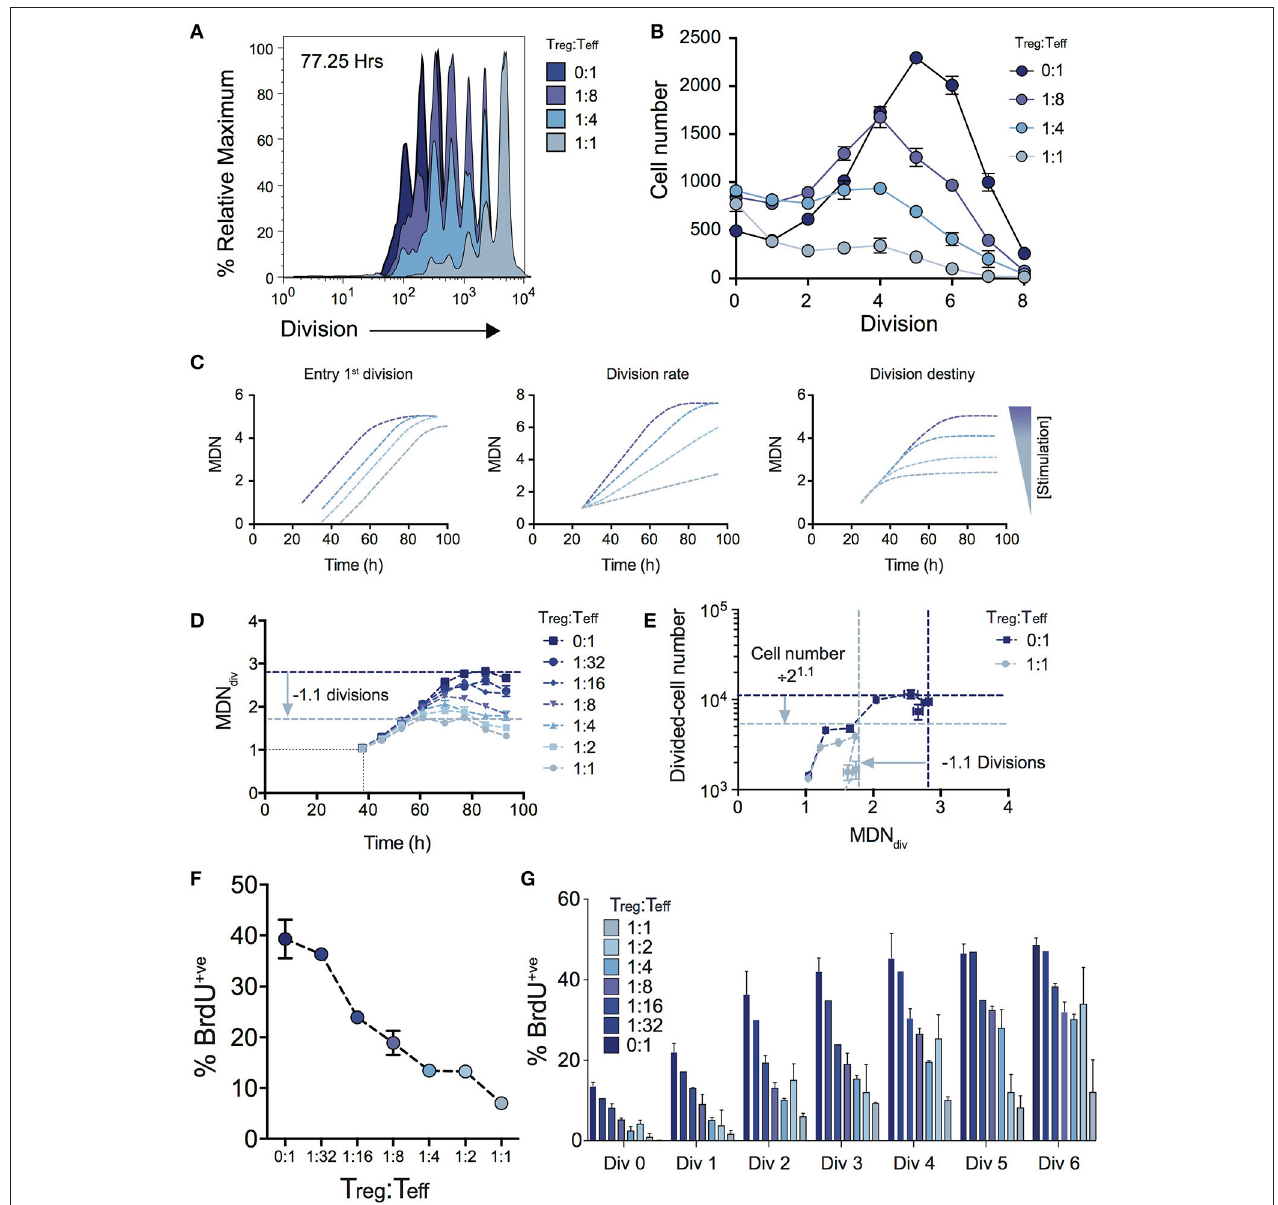
FIGURE 2 | Using cohort analysis to dissect the effect of Tregs on Teff cell division. (A) Cell division profiles of Teff cells at 77.25 hours with varying ratios of Tregs. (B) Cell numbers per division at 77.25 h as determined by quantification to a known number of added beads. (C) Cohort plot examples illustrating how trends in graphs are altered by changes in mean time to 1st division, the subsequent division rate and division destiny, as labeled. MDN - mean division number. (D) Cohort analysis plot of Mean division number of divided Teff cells over time (cohort method, excluding undivided cells). (E) Divided Teff cell number (excluding undivided cells) vs. mean division number of divided cells (cohort method) in the presence and absence of Tregs. The darker horizontal and vertical dashed lines indicate division destiny in the absence of Tregs, the lighter dashed lines indicate the reduction in division destiny at the maximum ratio of Tregs:Teffs (1:1), and the predicted reduction in total live cell number. BrdU incorporation at 63h as a function of Treg:Teff ratio for the total culture (F) and per division basis (G) during a 2h BrdU pulse. Data shown are mean + /– SEM of triplicate samples. One representative data set from three independent experiments is